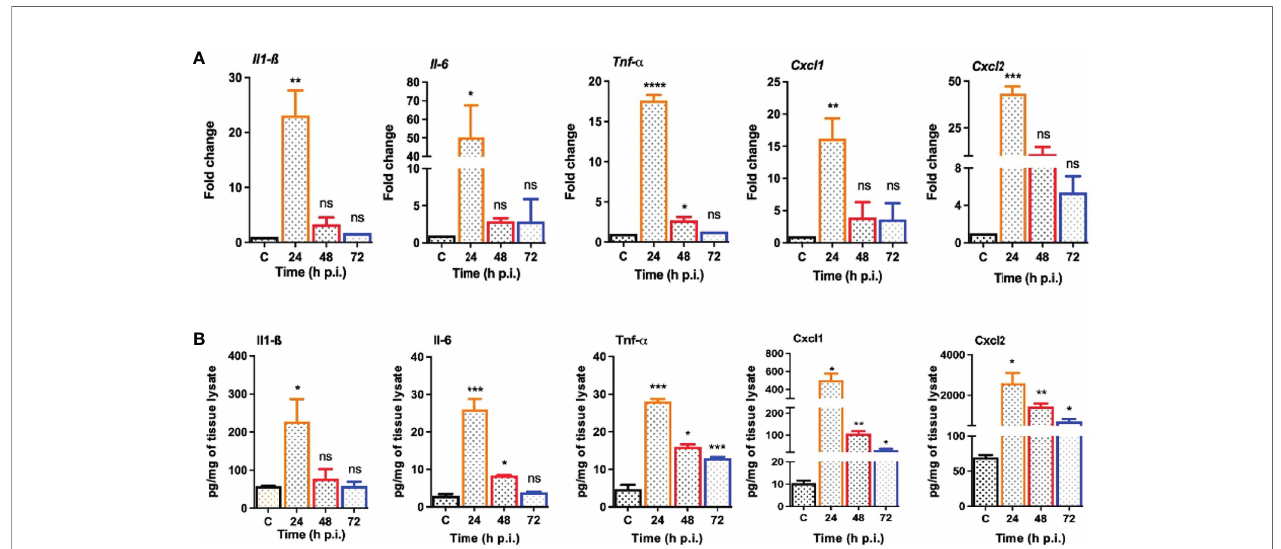
FIGURE 3 | S. epidermidis infected eyes exhibit in fl ammatory response during endophthalmitis. C57BL/6 mice eyes (n = 6 eyes at each time point) were infected by intravitreal injection of 10 7 cfu/eye of S. epidermidis or PBS (control, C) for indicated time points. (A) At designated time points, neural retina was harvested and subjected to qPCR analysis for in fl ammatory mediators, Il-1 b , Il-6 , Tnf- a , Cxcl1 , and Cxcl2 . (B) Whole eye lysates were subjected to ELISA to quantify the protein levels of the same in fl ammatory mediators. Statistical analysis was performed using ANOVA with Dunnett ’ s multiple comparison test (A, B) , (*) p<0.05 (**) p<0.01 (***) p<0.001 (****) p<0.0001; ns, nonsigni fi cant.